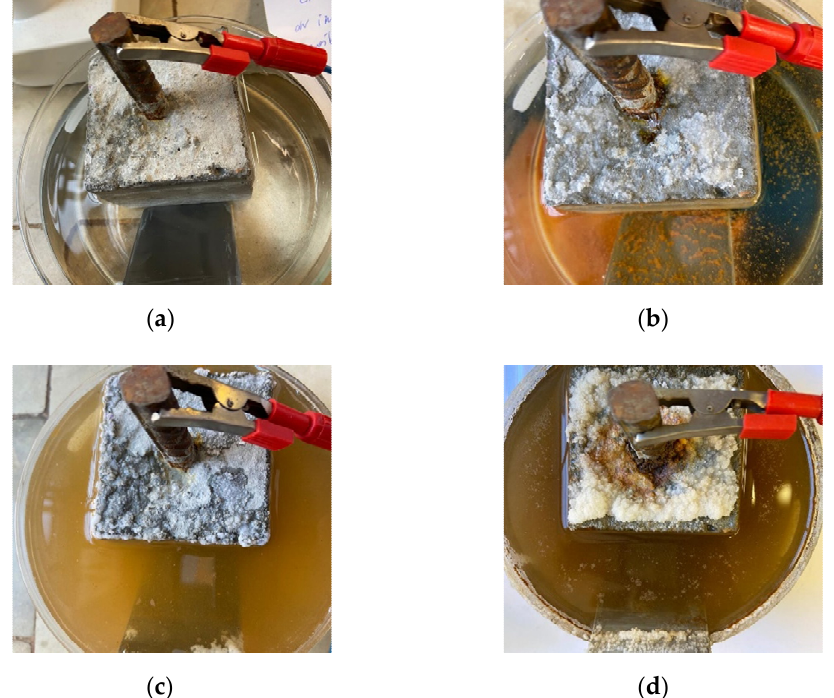
Figure 6. Corrosion acceleration experiment of single rebar: ( a ) first day of the experiment, immersing a concrete cube with rebar in a NaCl solution, ( b ) 14th day of the experiment, noticeable first corrosion changes within the rebar, ( c ) 42nd day of the experiment, increased rebar corrosion, beginning of salt crystallization on the concrete cube, ( d ) 70th day of the experiment, strong corrosion of the rebar radiating to the concrete cube, extensive salt crystallization.